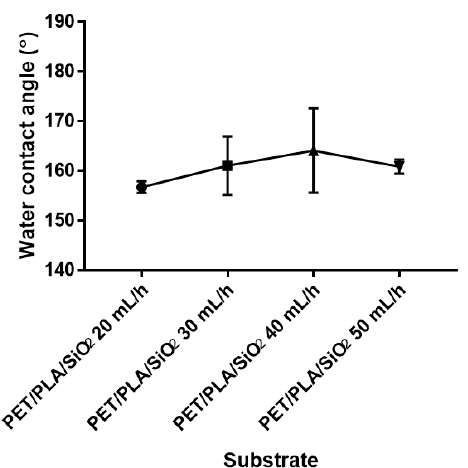
Figure 6. Apparent water contact angle of polyethylene terephthalate (PET)/polylactide (PLA)/silica (SiO 2 ) films at the electrospraying flow-rates of 20 mL/h, 30 mL/h, 40 mL/h, and 50 mL/h.